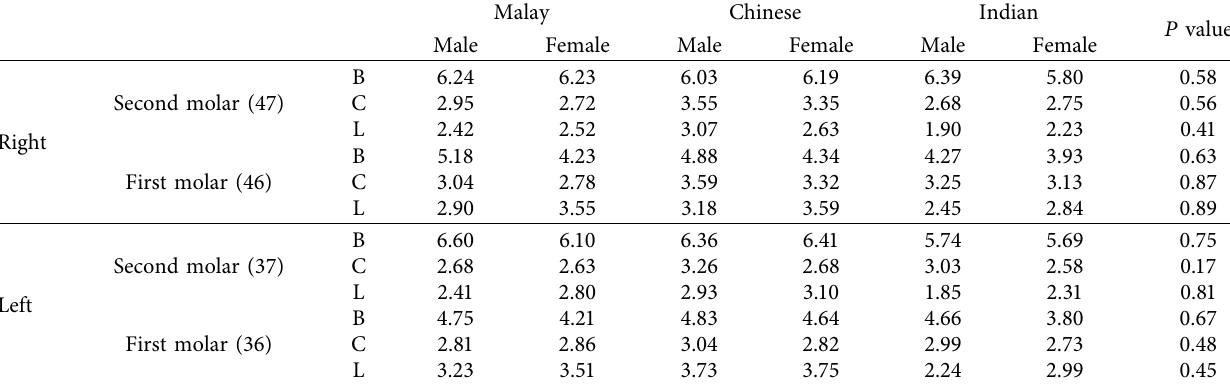
Table 5: Two-way ANOVA results showing the ethnicity-sex variations in the mean values of B, C, and